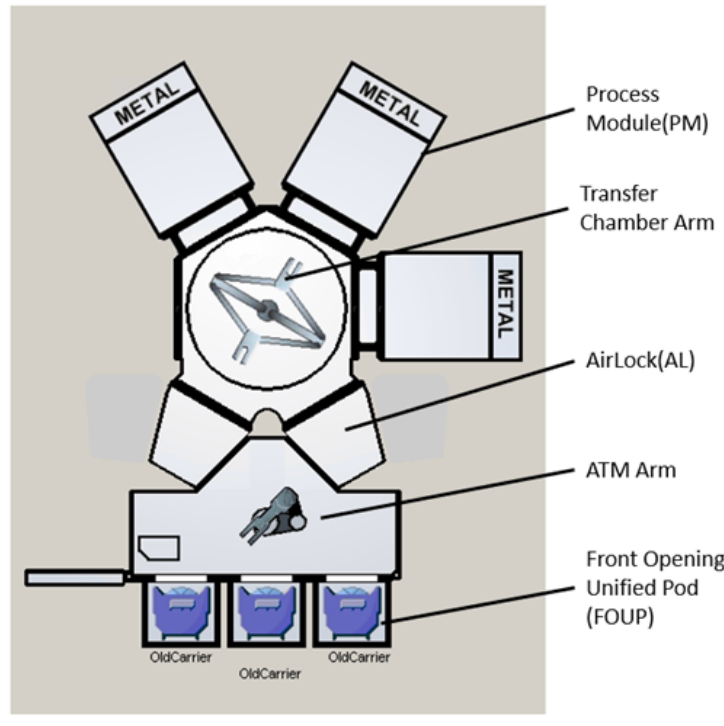
Figure 1. Cluster facilities including three PM, two AL, and three